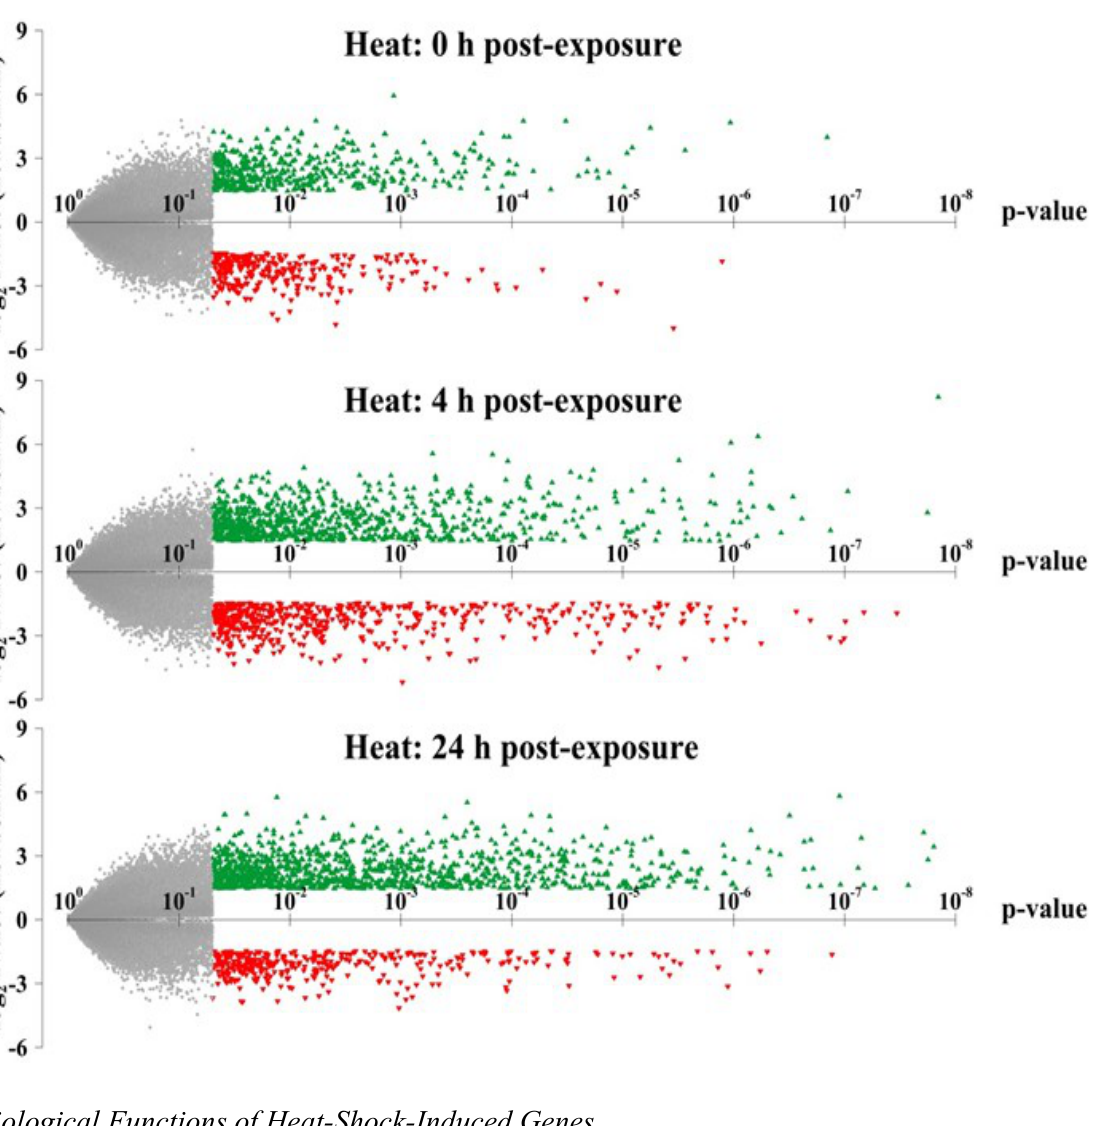
Figure 2. Volcano plots of the gene expression profiles at each time point. The magnitude of differential expression (log fold-change) is plotted versus the level of statistical significance 2 ( p -value) of all genes in the microarray for 0, 4 and 24 h post-heat exposure. Upregulated and downregulated genes with absolute log ratios  1.5 and p -values ≤0.05 are depicted with 2 green and red triangle symbols, respectively. Insignificant genes are denoted with light gray